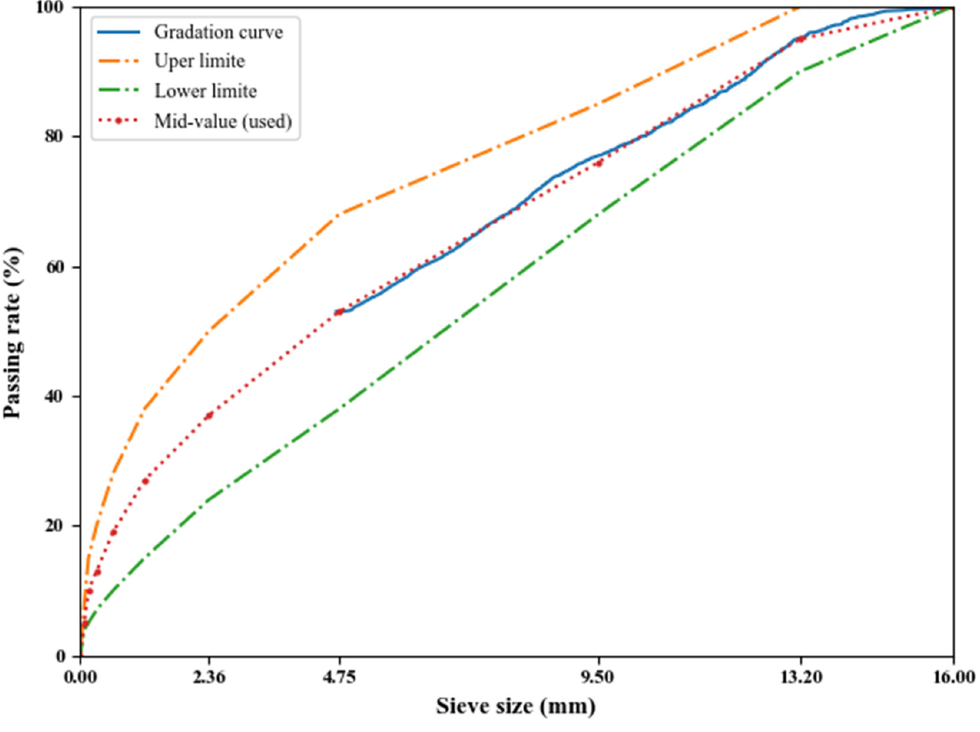
Figure 3. Gradation curve of the specimen. Table 1. Thermal and electromagnetic parameters of asphalt mortar.